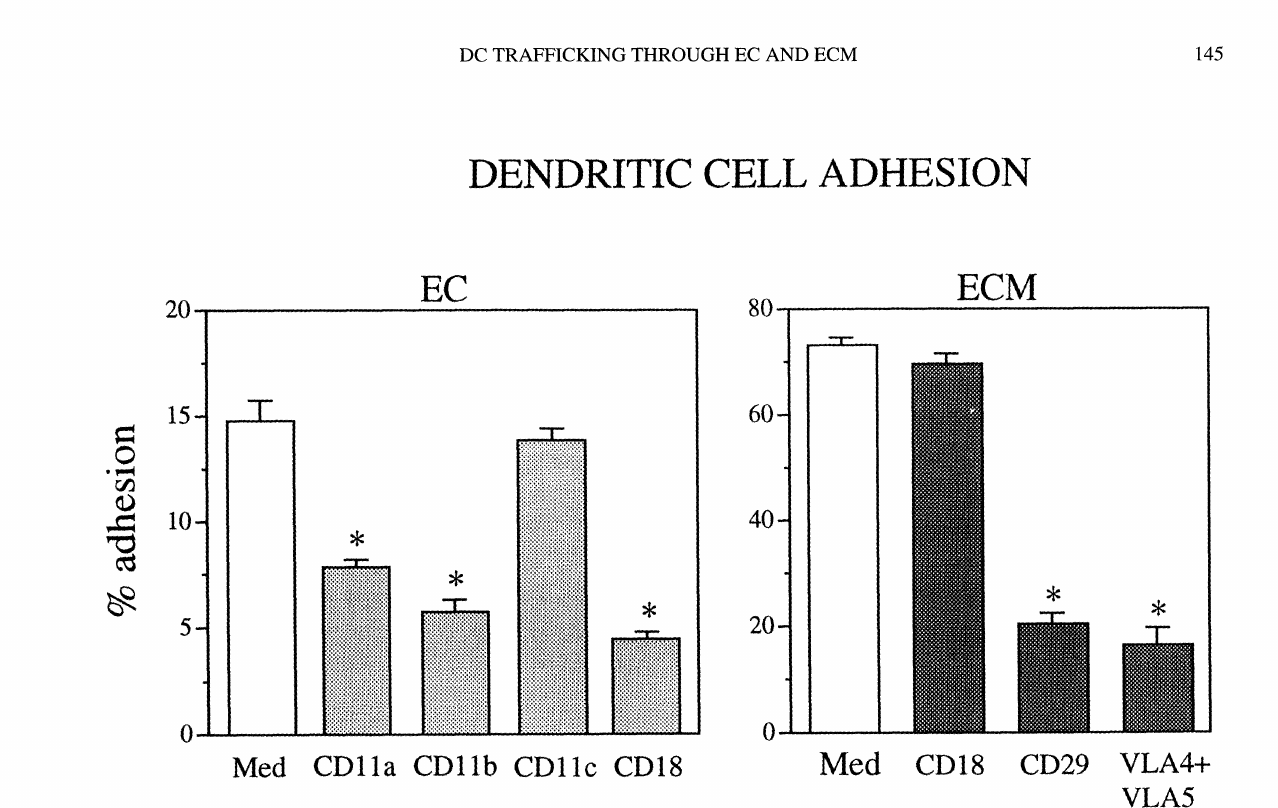
FIGURE Molecules involved in the adhesion of DC to resting EC (A) and to EC-derived matrix (ECM) (B). DC were differentiated from blood monocytes by 7-day culture with 50 ng/ml GM-CSF and 10 ng/ml IL-13.51Cr_labeled DC were preincubated for 20 min at room tem- perature with the indicated mAb, thereafter DC were co-incubated for lh at 37C. Results are expressed as % of adherent cells, mean+SE of three replicates. ECM was prepared by culturing a monolayer of EC on policarbonate filters for at least 5 days; EC were then stripped by a NH4OH + Triton x-100 solution for 30